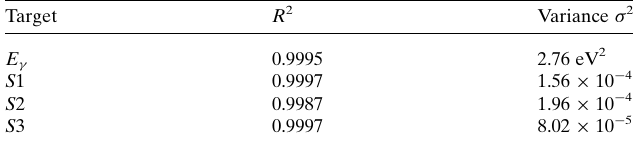
Table 6 Properties of the Calibrated model’s predicted beam characteristics from the 68 test